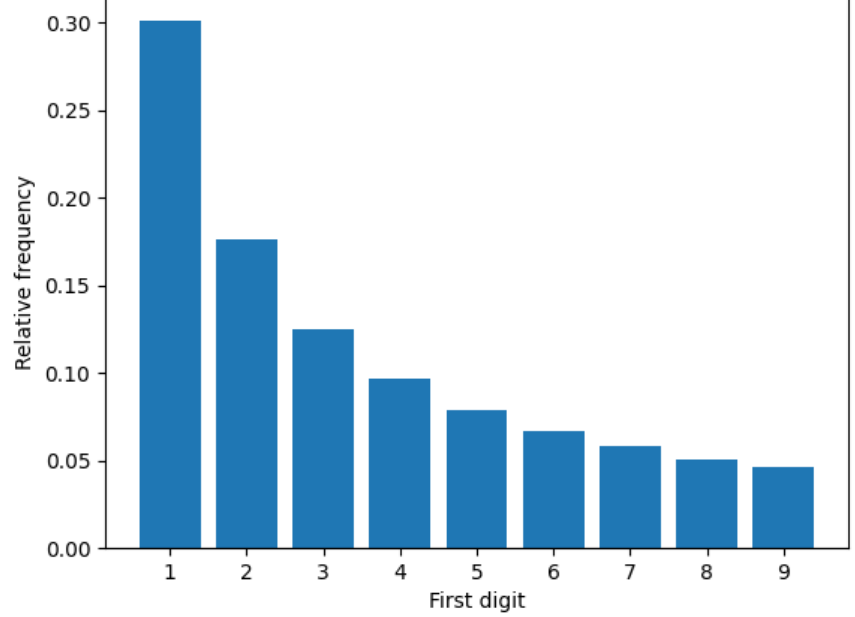
Figure 1. Distribution of first digits in natural datasets according to Benford’s law. Each bar represents a digit, and the height is proportional to the relative frequency of numbers that begin with that